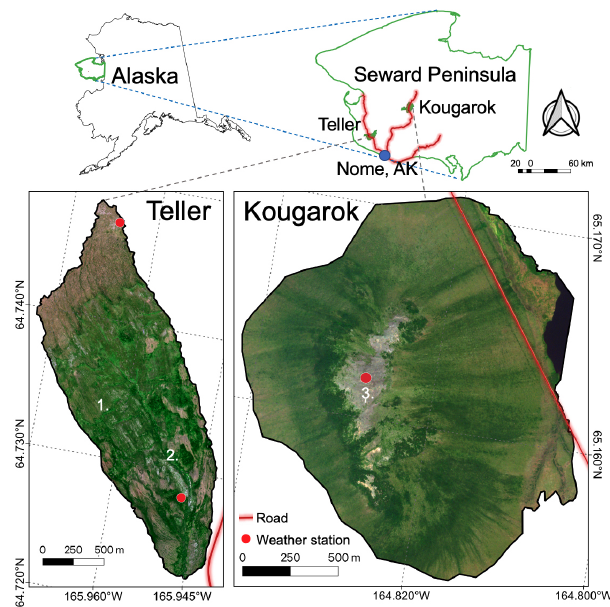
Figure 1. Location and WorldView-2 RGB imagery of the Teller watershed (lower left) and Kougarok Hillslope study sites (lower right). Teller has two weather stations (red dots), located near the top and bottom of the watershed, and the Kougarok Hillslope has one weather station located near the top of the rocky dome. The sites are located on the Seward Peninsula of Alaska, with the HUC12 basins for the Teller watershed and the Kougarok Hillslope shown in green and the Seward Peninsula road system in red (upper right). RGB composite from the eight-band WorldView-2 images obtained on 27 July 2011 (Teller) and 14 July 2017 (Kougarok Hill- slope) at 1.5m resolution downloaded from the DigitalGlobe web- site (https://www.maxar.com/, last access: 29 July 2022) Imagery © 2011/2017 Maxar. Example of features discussed in the text are denoted on the map as (1) terraces and risers, (2) the Teller water- shed stream bed, and (3) the Kougarok Hillslope